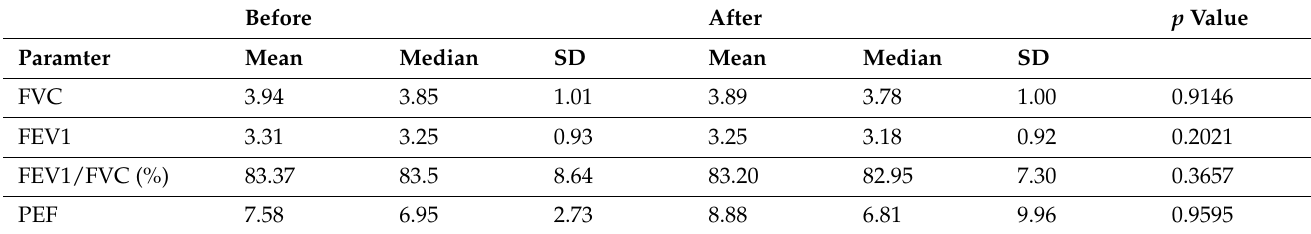
Table 10. Results of the spirometry examination of the FFP3 mask using the Wilcoxon signed-rank test. A p value < 0.05 was considered statistically significant. Statistically significant results are shown in